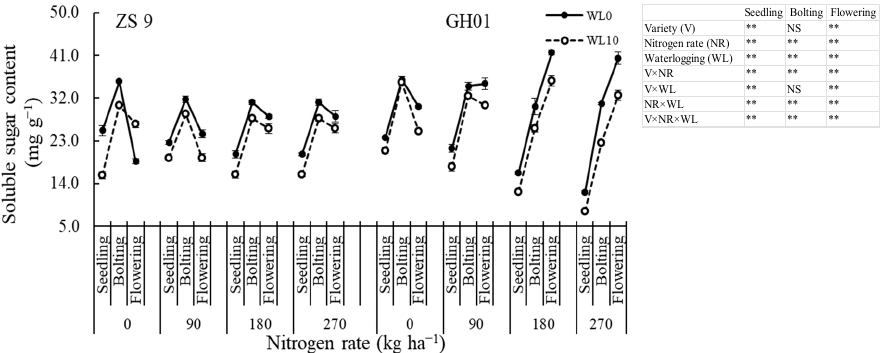
Figure 5. Effects of nitrogen rates on leaf soluble sugar content of waterlogged rapeseed. WL0, plants without waterlogging; WL10, plants waterlogged for 10 days at the seedling stage. ** Significant at the 0.01 probability level. NS, not significant according to ANOVA.